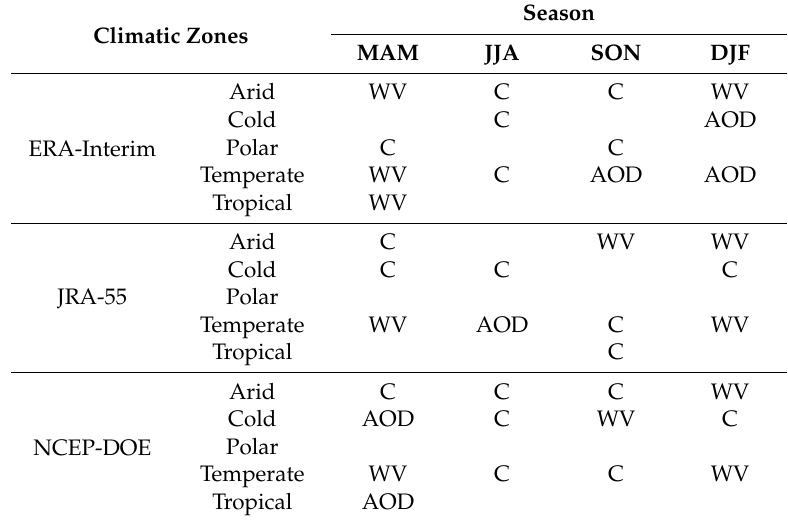
Table 4. Influence factors of three products in the different seasons and different climatic zones. Season Climatic Zones MAM JJA SON DJF Arid WV C C WV Cold C AOD Polar C C ERA-Interim Temperate WV AOD AOD Arid Polar Temperate WV AOD C WV Tropical C Arid C C WV Cold AOD Polar NCEP-DOE Temperate WV